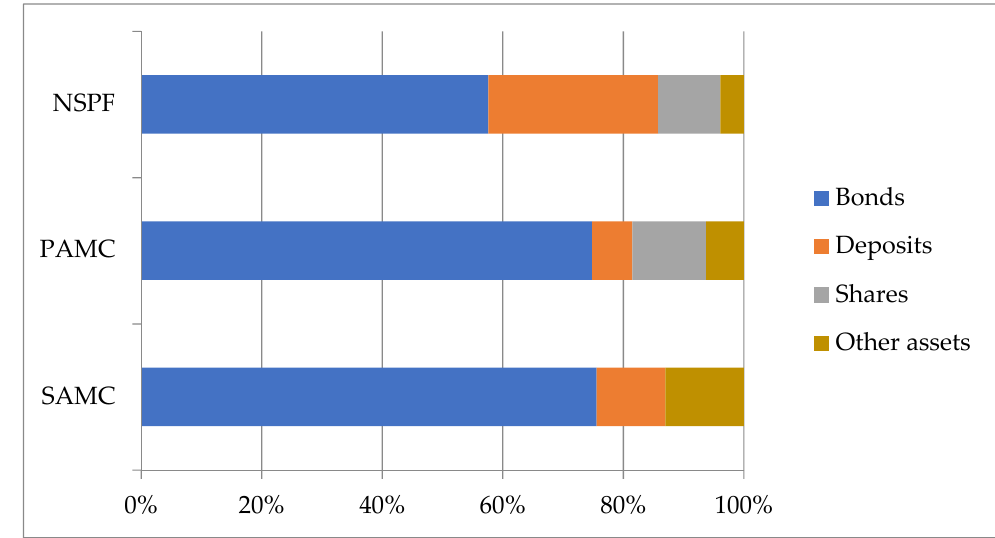
Figure 7. Composition and structure of portfolios of pension investors on average for 2008–2018.